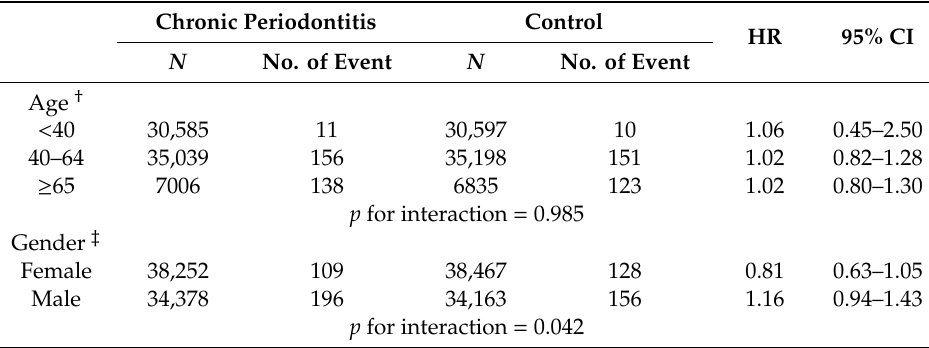
Table 3. Subgroup analysis of hazard ratios of chronic periodontitis.